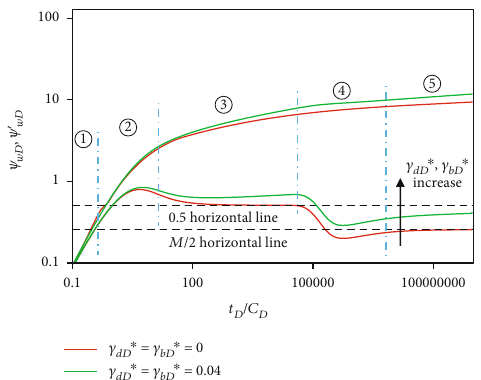
Figure 6: Well test curves for the pressure drawdown well test in composite gas reservoir.